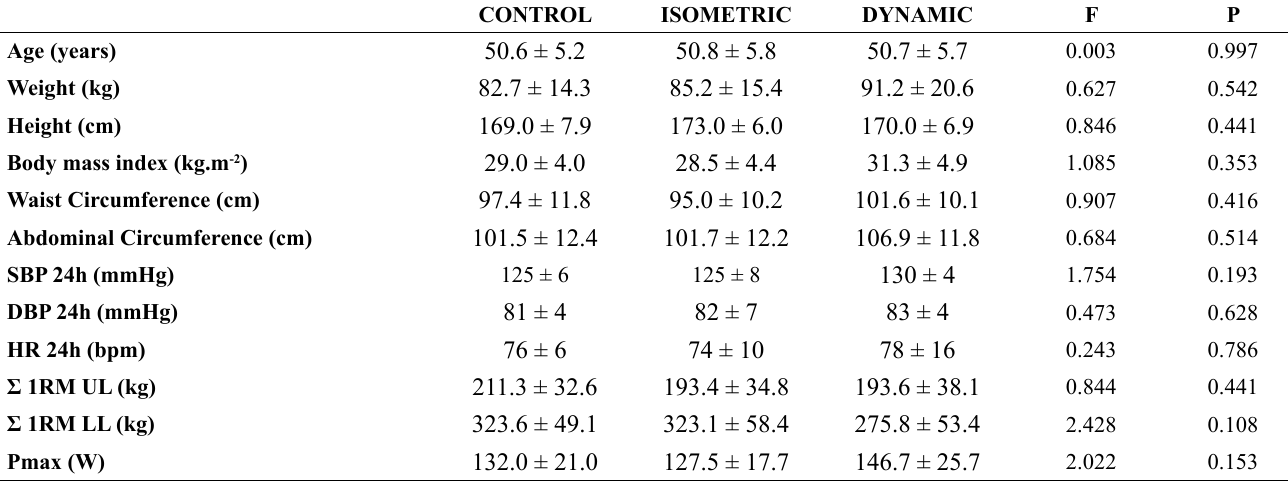
Table 1. Mean (±SD) of the sample’s main characteristics.